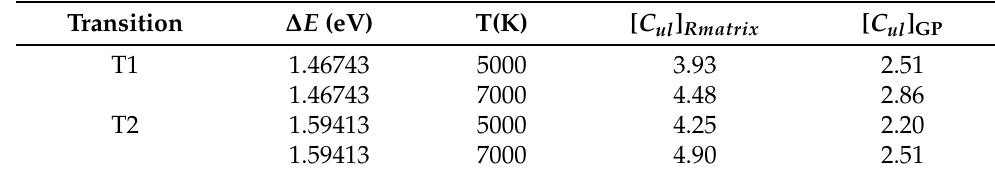
Table 3. De-excitation rates obtained for T1 and T2 transitions of the oxygen by collisions with electrons. The rates [ C ul ] GP are calculated via Equation (4), and [ C ul ] Rmatrix are obtained by directly averaging R-matrix quantum cross-sections via Equations (1) and (2). The rates are expressed in ( 10 − 7 cm 3 s − 1 )